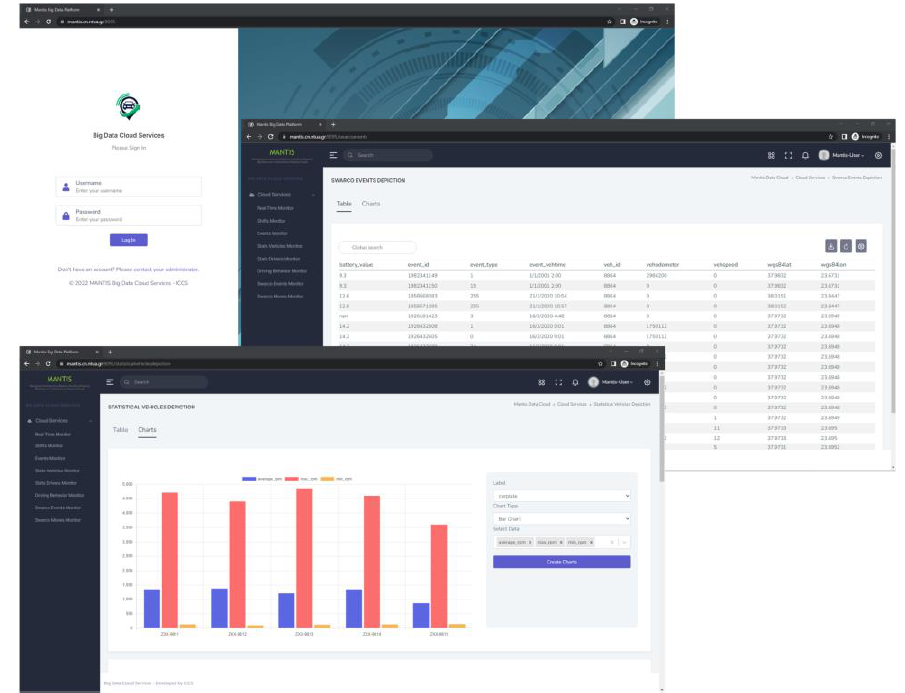
Figure 9. GUI of the DBDA platform.